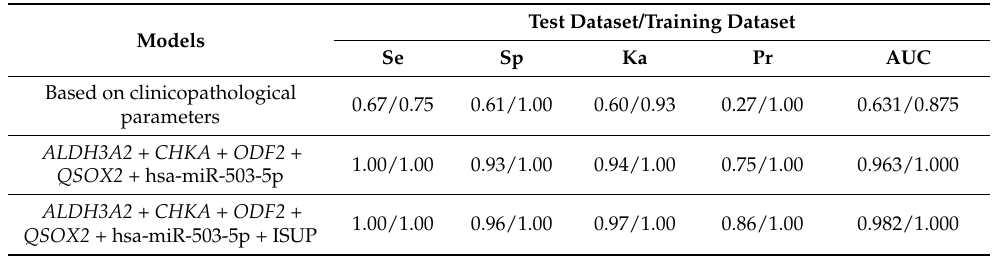
Figure 4. ROC-curve of predictive models of the test dataset. AUC—area under the error curve. Further models based on the RNA-Seq expression data for four genes ( ALDH3A2 , CHKA , ODF2 , and QSOX2 ) and miRNA-Seq expression data of two miRNAs (hsa-miR- 503-5p and hsa-miR-200b-3p) were created and tested. The most prospective predictive model to forecast the biochemical recurrence when looking at the primary tumor of locally advanced PCa was that based on changes in the expression of four mRNAs and one miRNA ( ALDH3A2 + CHKA + ODF2 + QSOX2 + hsa-miR-503-5p, Figure 4, Tables 3 and S7). Table 3. Metrics of predictive models. Se—sensitivity, Sp—specificity, Ka—kappa (normalized proportion of correct answers), Pr—precision, AUC—area under the error curve.